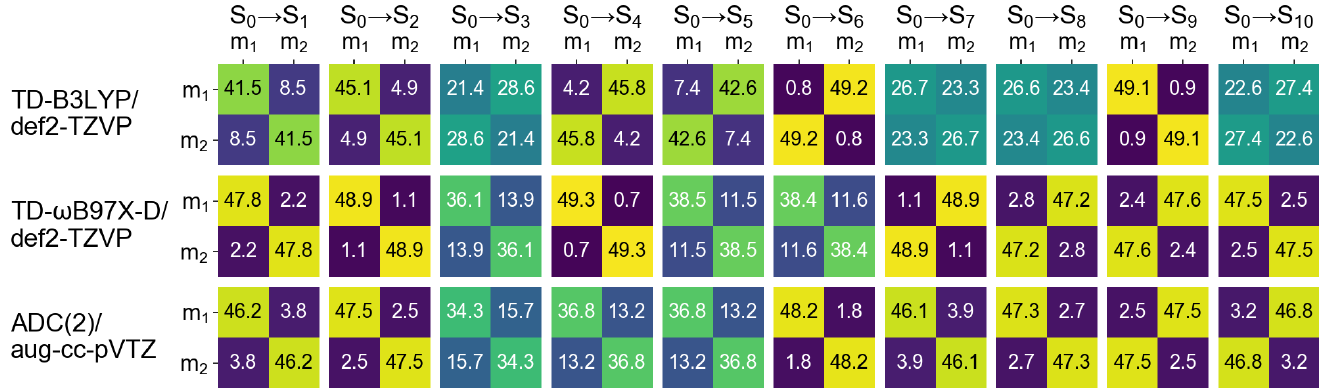
Figure 6. 5 F matrices for the lowest ten transitions of the cofacial π -stacked dimer d = 3.5 Å calculated at the TD- B3LYP/def2-TZVP ( top row ), TD- ω B97X-D/def2-TZVP ( middle row ), and ADC(2)/aug-cc-pVTZ ( bottom row ) levels of theory. X , Y = m 1 ,m 2 ; m stands for